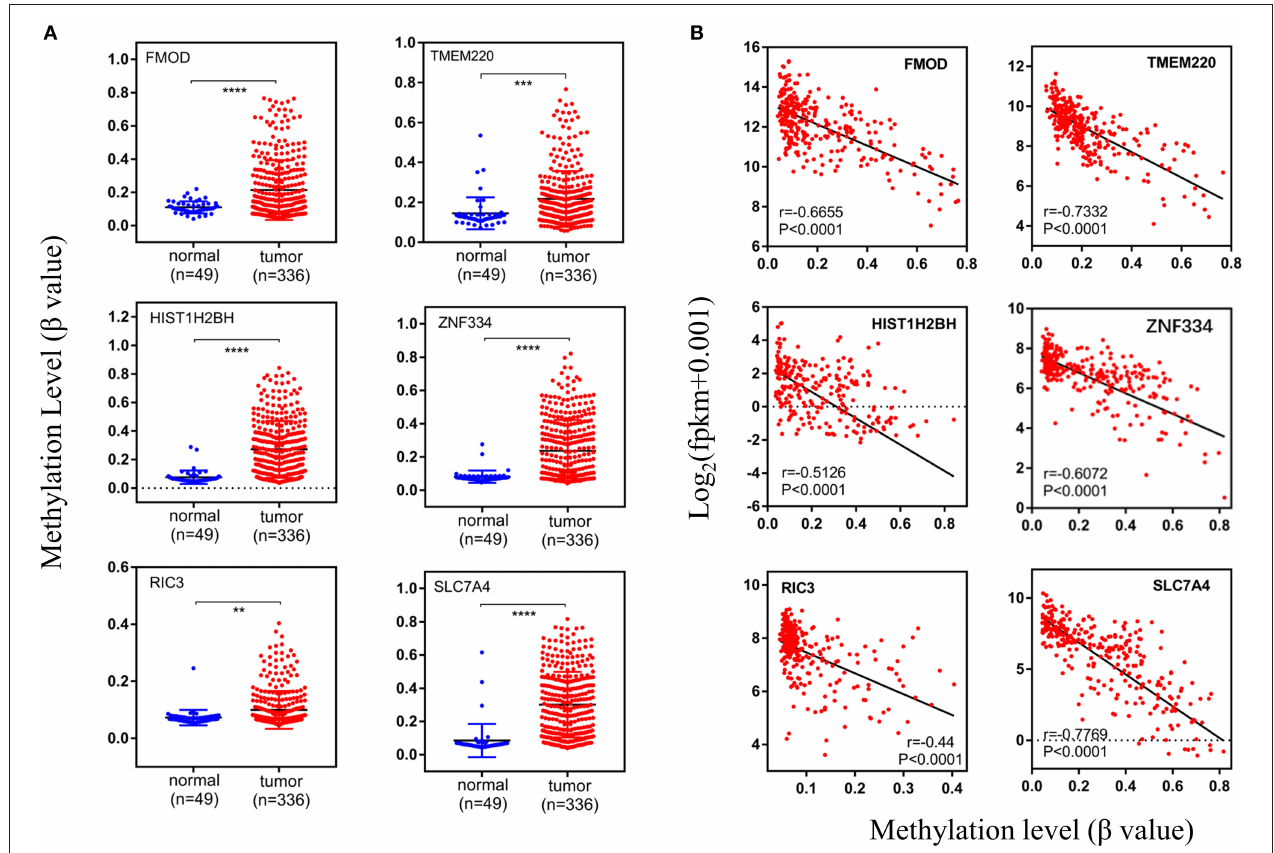
FIGURE 8 | Methylation levels of specific genes. (A) The methylation levels in normal and tumor groups, (B) the relationship between expression level and methylation level. The vertical axis of (A) and the horizontal axis of (B) indicate the DNA methylation level ( β -value). And r represents the Pearson’s correlation coefficient, the absolute value closer to 1 means the stronger the correlation. fpkm, fragments per kilobase